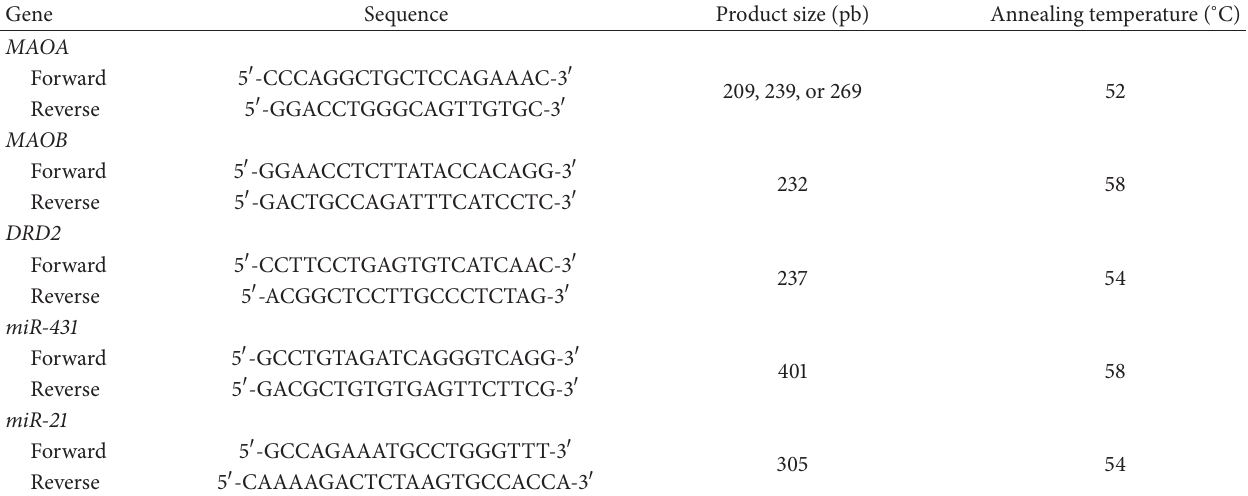
Table 1: Primer sequences of